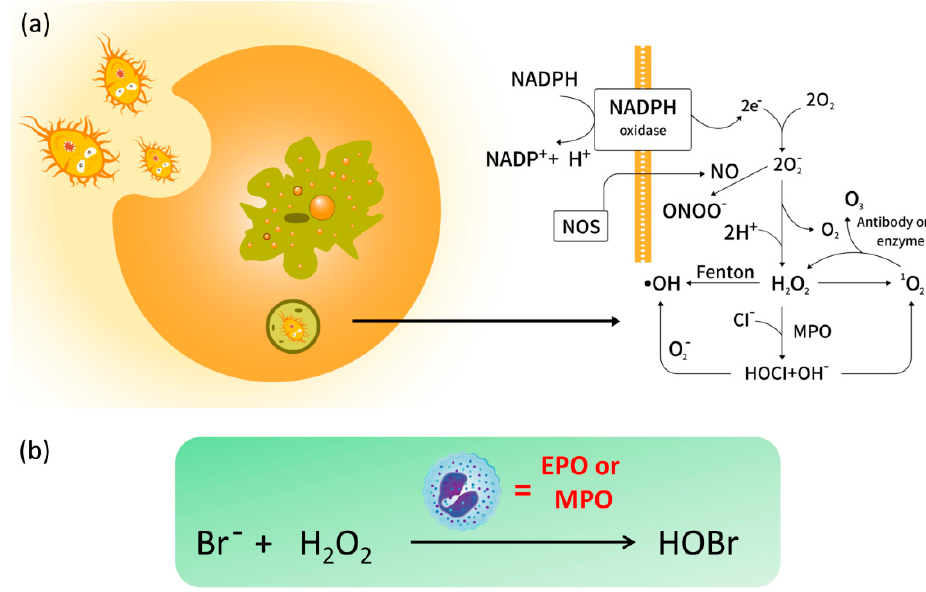
Figure 1. ( a ) The intracellular generation of reactive oxygen species (ROS) and ( b ) the formation of endogenous hypobromous acid (HOBr) catalyzed by eosinophil peroxidase (EPO) or myeloperoxidase (MPO).